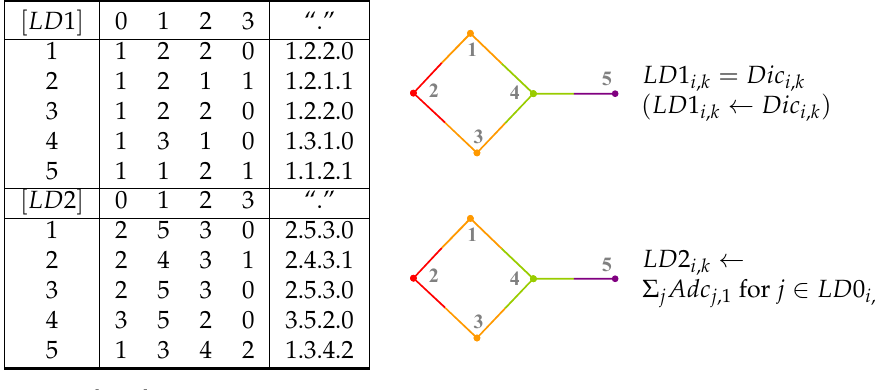
Figure 8. [ LD 2 ] on Figure